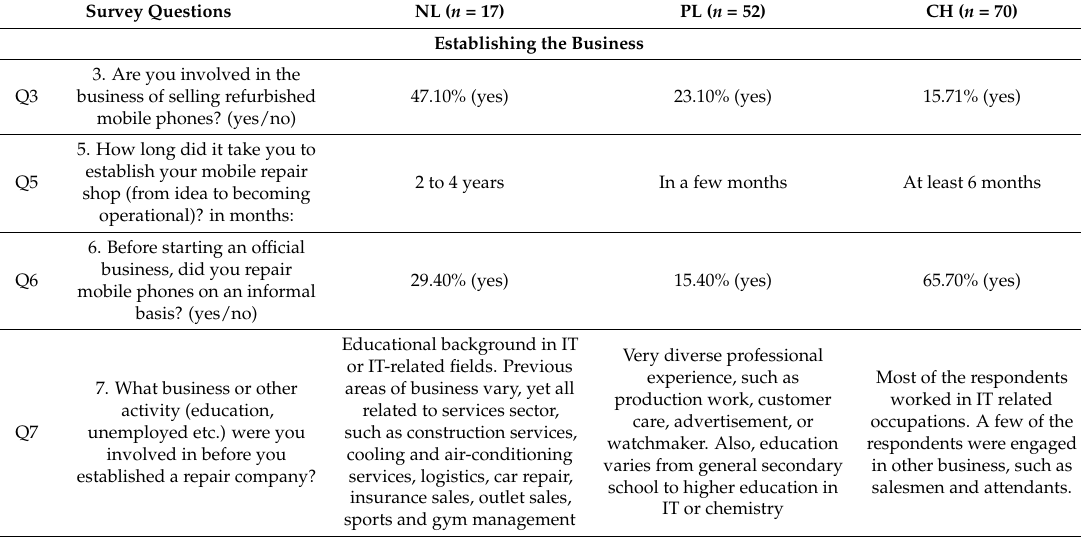
Table 2. Selected results from mobile phone repair shops